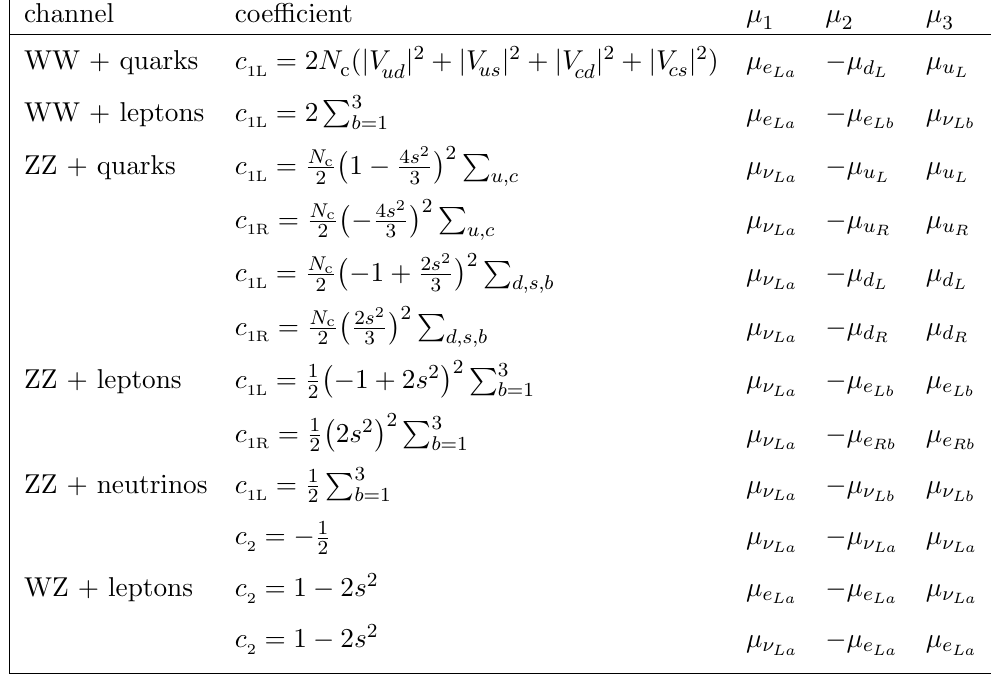
Table 2 . The coe(cid:14)cients and chemical potentials that appear in eq. (5.30), with s 2 (cid:17) sin 2 ( (cid:18) ). Each \channel" is labelled by the gauge bosons and fermions participating in the reaction. For clarity we have assigned separate chemical potentials to di(cid:11)erent chiral states, but when eq. (3.6) is satis(cid:12)ed as is necessary for a quasiparticle picture, the chemical potentials of chiral partners coincide, cf. table